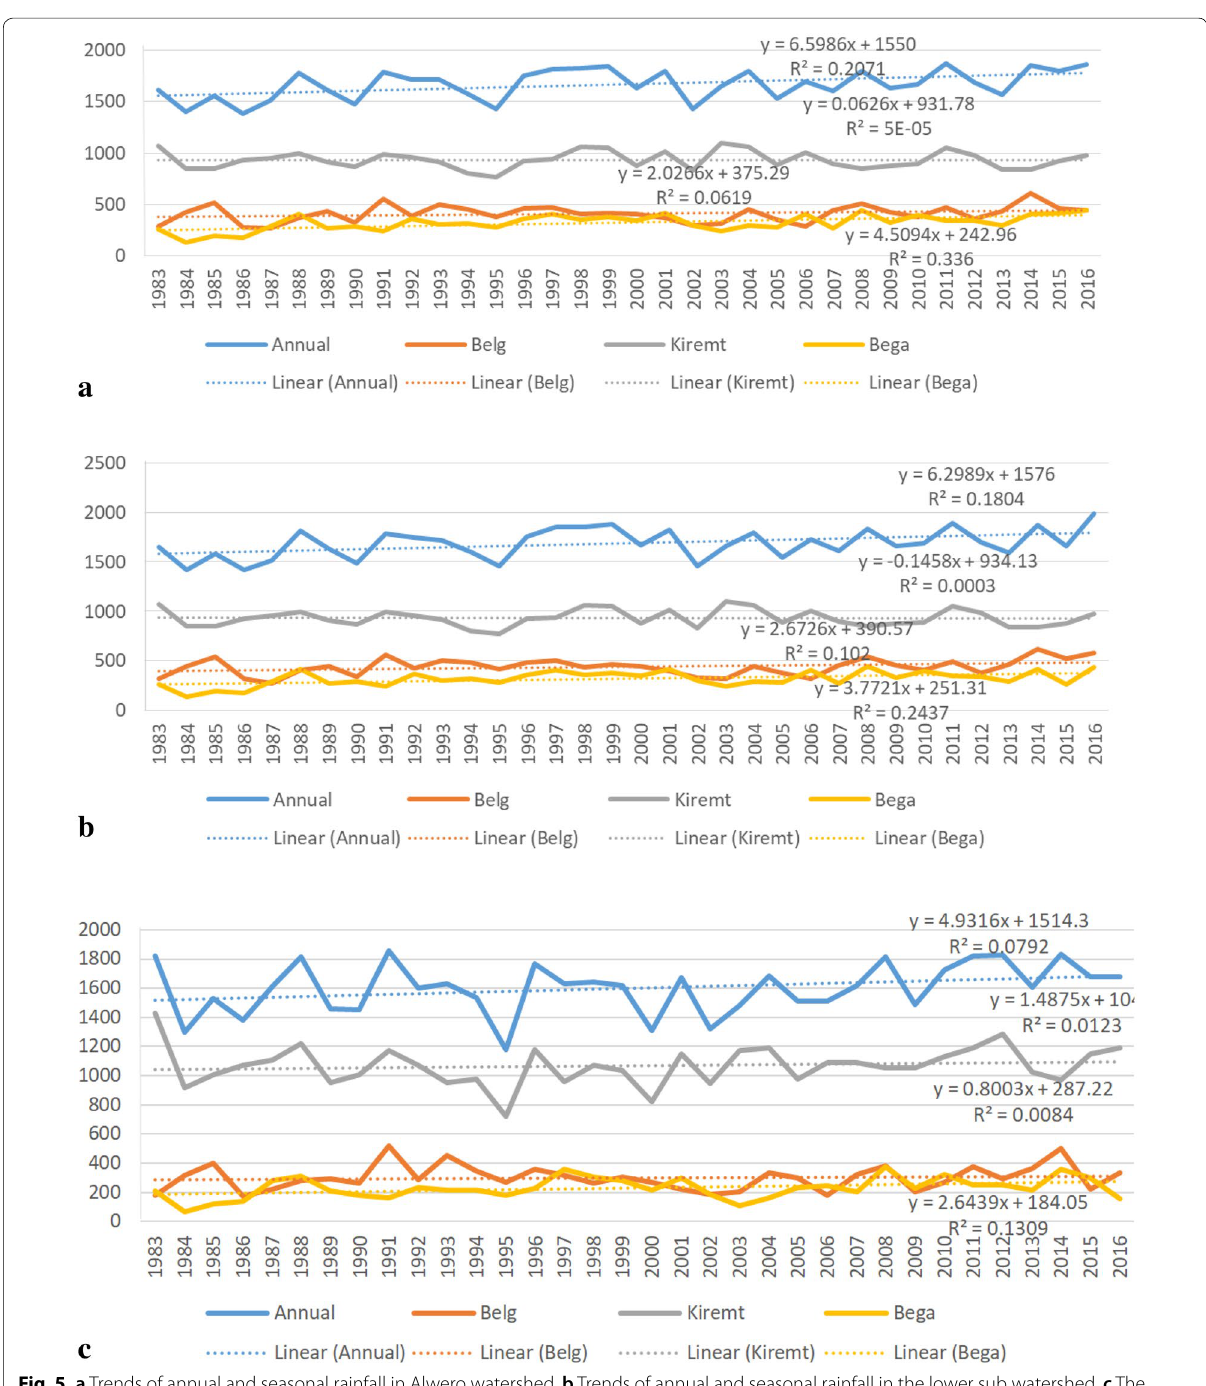
Fig. 5 a Trends of annual and seasonal rainfall in Alwero watershed. b Trends of annual and seasonal rainfall in the lower sub watershed. c The Trends of annual and seasonal rainfall in the upper sub